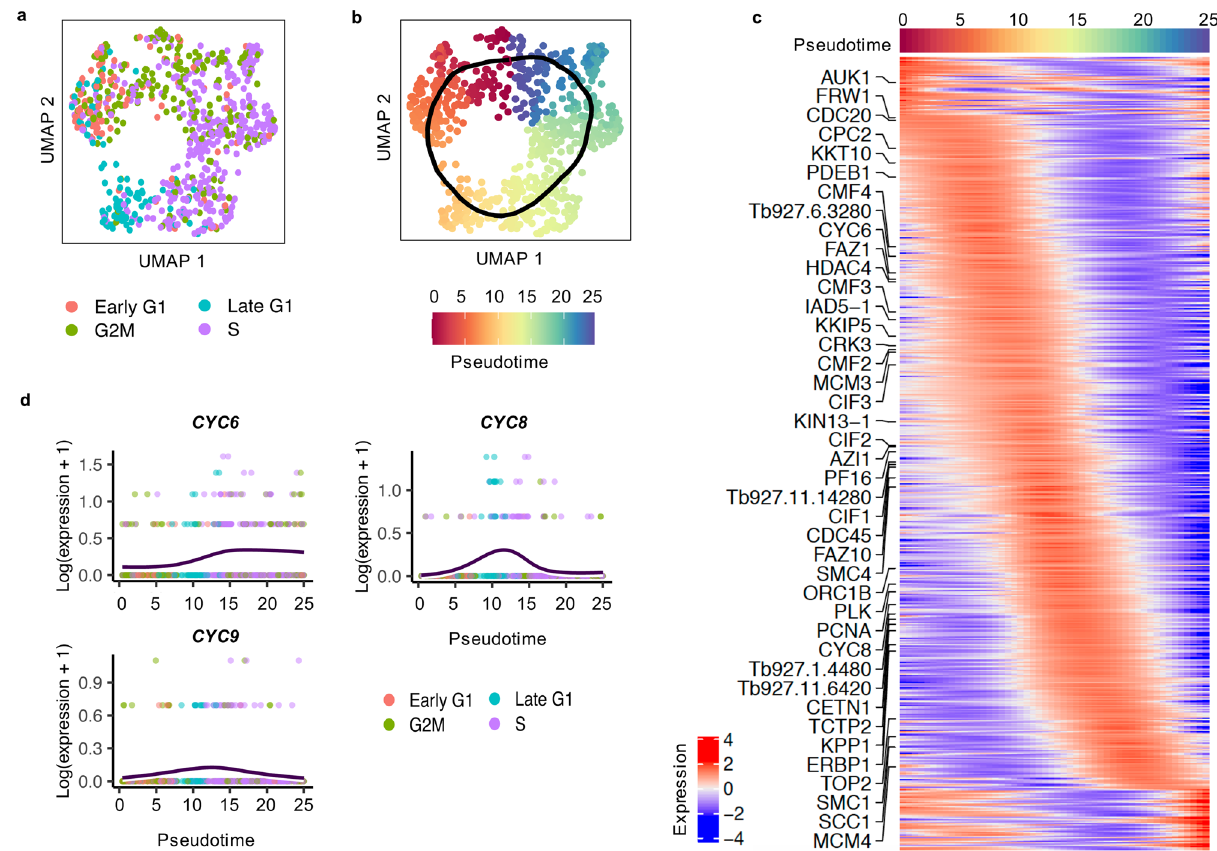
Fig. 4 Identi fi cation of genes differentially expressed during the slender form cell cycle. a UMAP of only cycling (as labelled in Fig. 3a) slender A and slender B cells re-plotted, using genes variable within the cycling slender population. Cells are coloured by cell-cycle phase: Early G1 in red, Late G1 in blue, S in purple, G2M in green. b UMAP of cycling slender cells coloured by assigned pseudotime value. The black line indicates the inferred circular trajectory. c Heatmap of relative expression levels (log2 normalised z-score) of genes signi fi cantly differentially expressed over the cell cycle (identify with associationTest; p -value > 0.05, FC > 2). Genes associated with the GO term “ cell cycle process ” are labelled. d Expression levels ( y -axis; log2(expression + 1)) of 3 cyclin genes ( CYC6, CYC8 and CYC9 ) over cell-cycle pseudotime ( x -axis). Each point is one cell coloured by cell-cycle phase (as in a ) and dark blue line shows smoothed average expression over